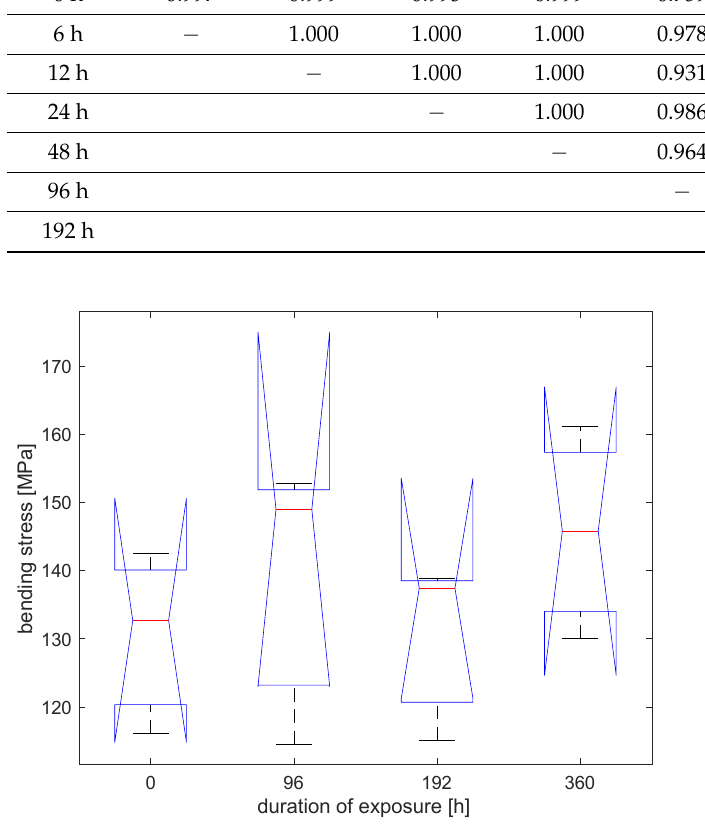
Figure 10. Box plot for the specimens with different durations of exposure to 40 °C. Table 4. p-values of the different groups of exposure to the temperature of 40 °C.